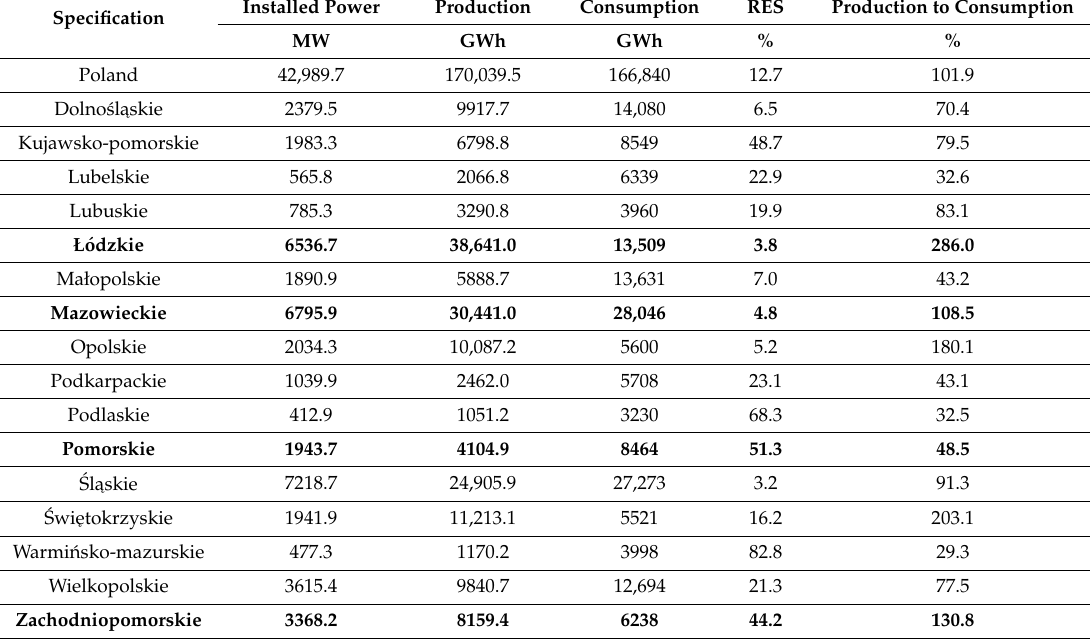
Table 2. Basic characteristics of the power sector in Poland in